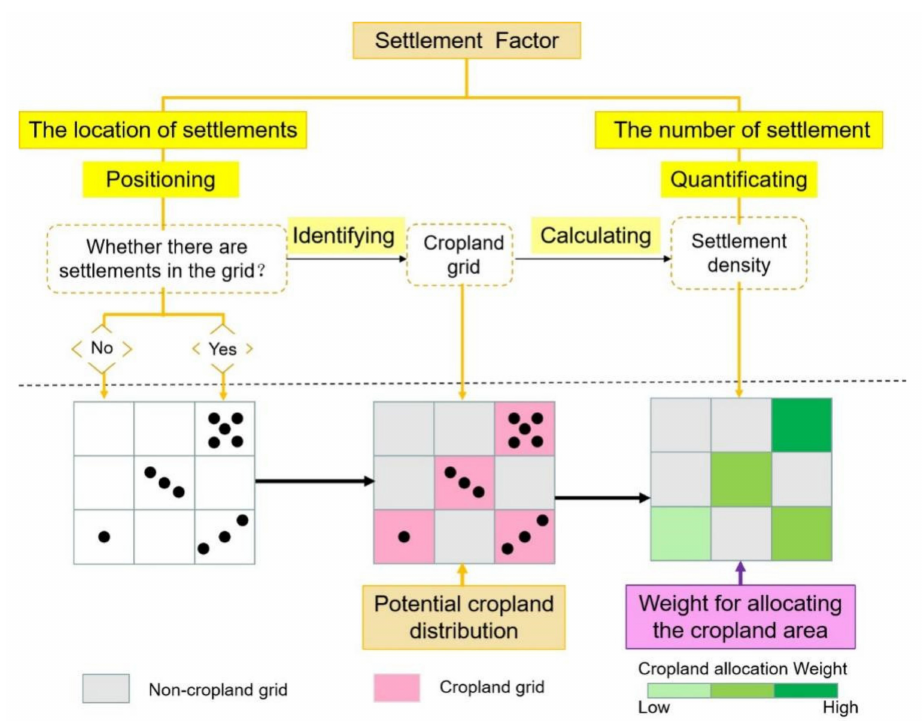
Figure 4. The framework for applying the settlement density-based cropland allocation